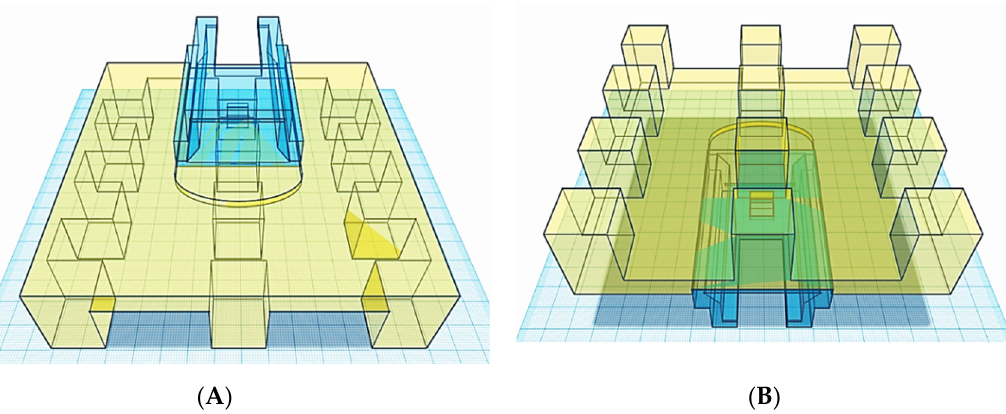
Figure 4. ( A ) Top and ( B ) bottom view of the CAD model used for the twelve-spots build platform ( 12 BP). Each square on the blue background corresponds to a surface area of 1 cm 2 .